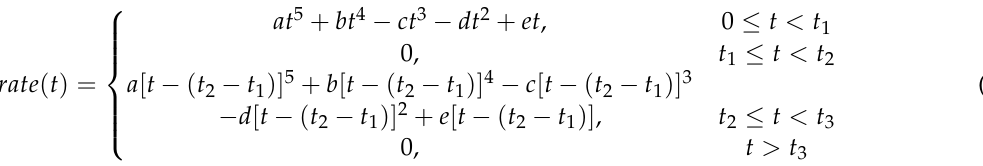
collision with the bottom plate, is considered a stable ejection. Before the simulation